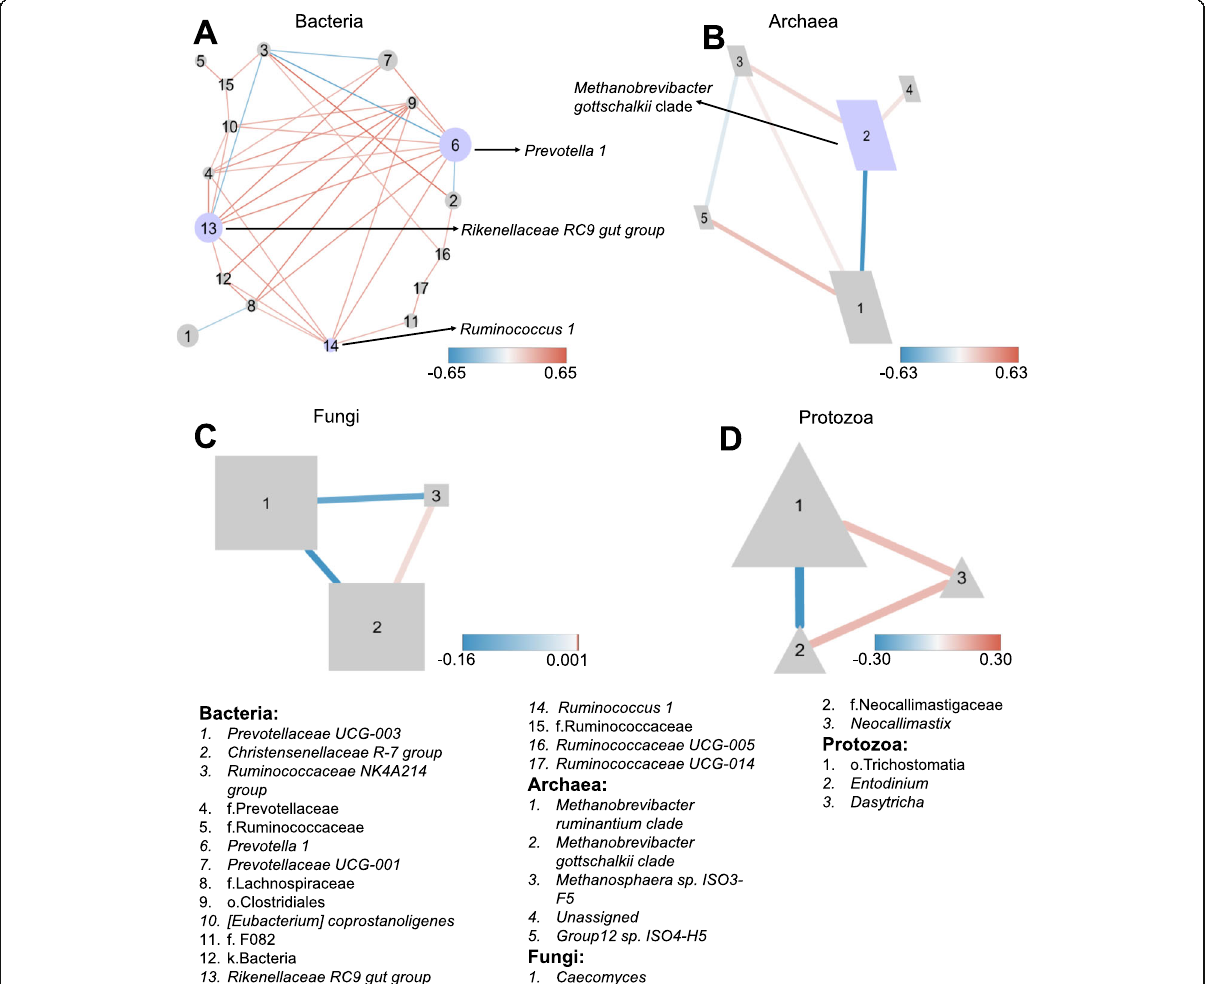
Fig. 6 Co-occurring network analysis of intra-interactions of core taxa in each rumen microbial kingdom. The association patterns of bacteria ( a ), archaea ( b ), fungi ( c ) and protozoa ( d ) from birth to adulthood. The size of each node is proportional to the relative abundance. The lines in red and blue denote positive and negative correlations, respectively. The nodes are referred to as keystone species and are highlighted in light purple, and the taxonomic names of keystone species are indicated in the networks. The taxonomic information of the nodes is shown at the bottom of the